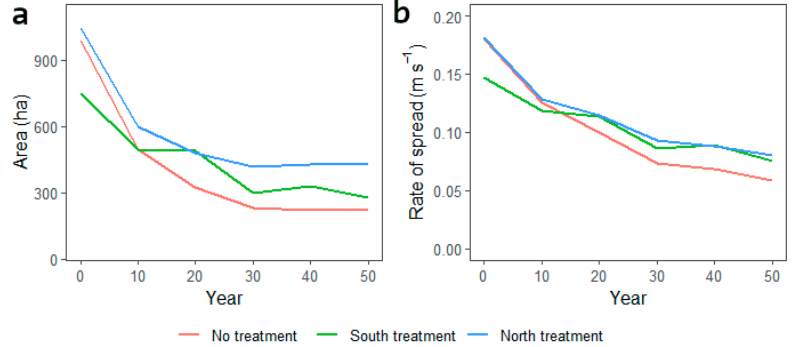
Figure 4. Fire size ( a ) and mean rate of spread ( b ) after 7.5 h of fire spread for all treatment cenarios.